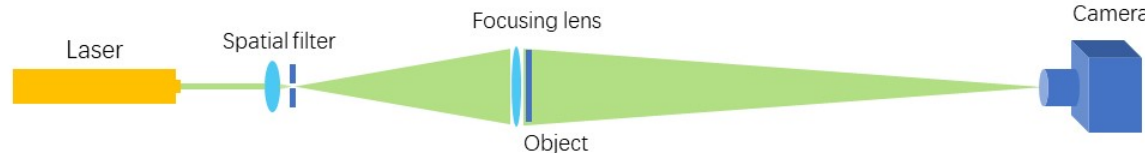
Figure 1. Macroscopic Fourier ptychography technique physical model. From left to right: The laser emits quasi-monochromatic light that passes through the spatial filter to the converging lens. The light field interacts with the object and converges at the camera lens plane. The lens shortens the distance conditions required for Fraunhofer diffraction, and the intensity image is finally captured by the camera.